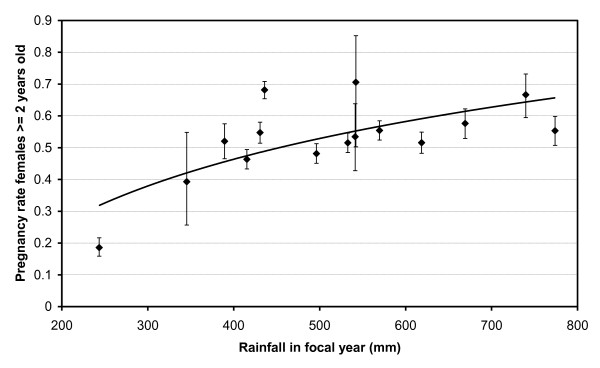
Correlation between annual pregnancy rate and rainfall in focal year. Error bars: 90% CI, Pspearman = 0.011, R2 = 0.51 (logarithmic relationship). Years run from Sept. till Aug.